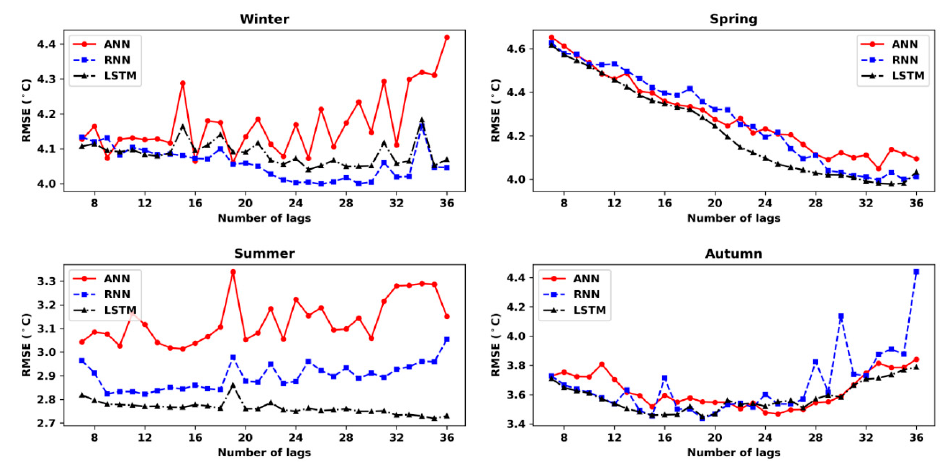
Figure9. Rootmeansquareerrorcorrespondingtodi ff erentnumberoflagsofthenext15daysprediction. Figure 9. Root mean square error corresponding to different number of lags of the next 15 days prediction.